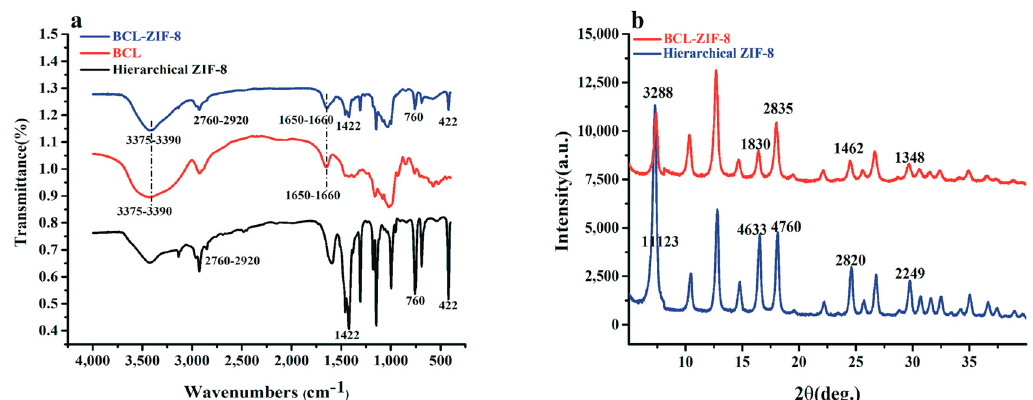
Figure 4. ( a) Fourier transform infrared (FT-IR) spectra of samples of hierarchical ZIF-8; BCL and BCL-ZIF-8; ( b ) powder X-ray diffraction (PXRD) patterns of samples of hierarchical ZIF-8 and BCL-ZIF-8.